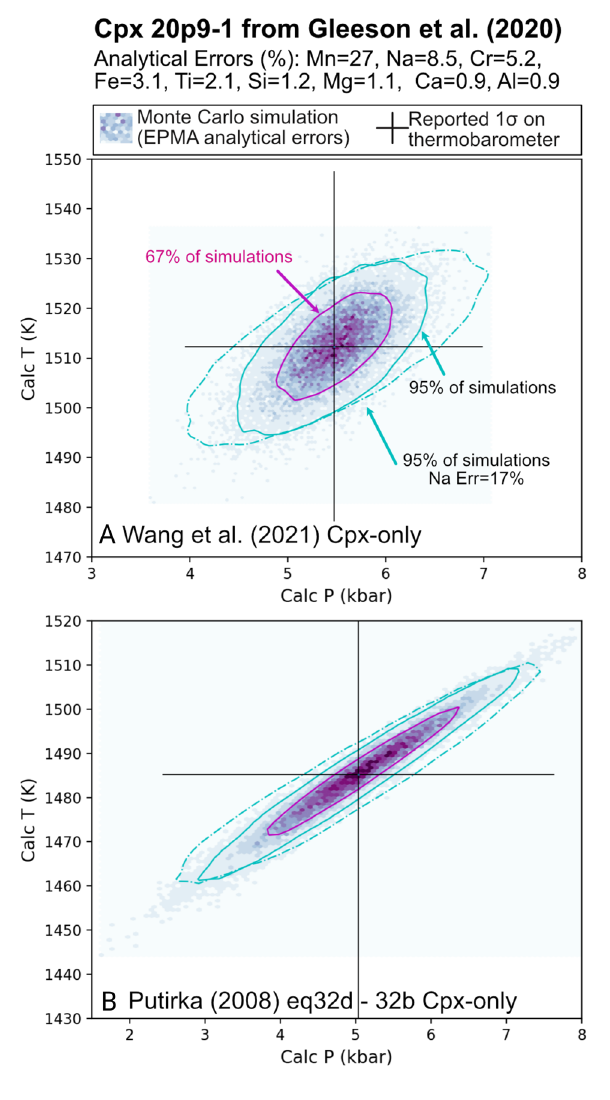
Figure 8: Propagated analytical errors from EPMA analyses into resulting distributions of pressures and temperatures. 1